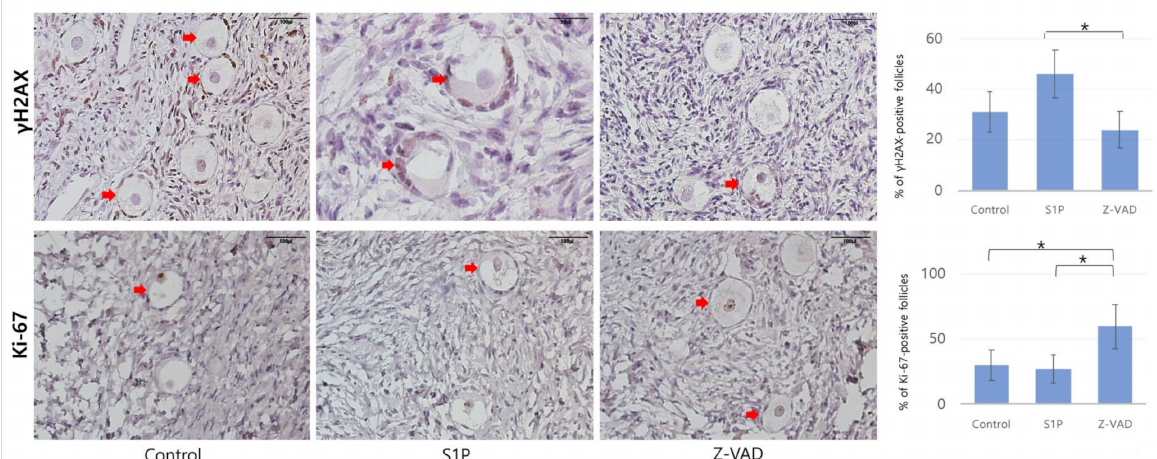
Figure 3. Histological features of frozen–thawed human ovarian tissues in the three groups evaluated with immunohis- tochemical staining for Ki-67 (magnification × 200, control: n = 19, S1P: n = 18, Z-VAD: n = 19, * p < 0.05) and γ H2AX (control and Z-VAD: magnification × 200, S1P: magnification × 400) (control: n = 18, S1P: n = 19, Z-VAD: n = 18, * p < 0.05). Red arrows indicate Ki-67-positive or gamma H2A histone family member X ( γ H2AX)-positive primordial follicles. S1P: sphingosine-1-phosphate, Z-VAD: Z-VAD-FMK.